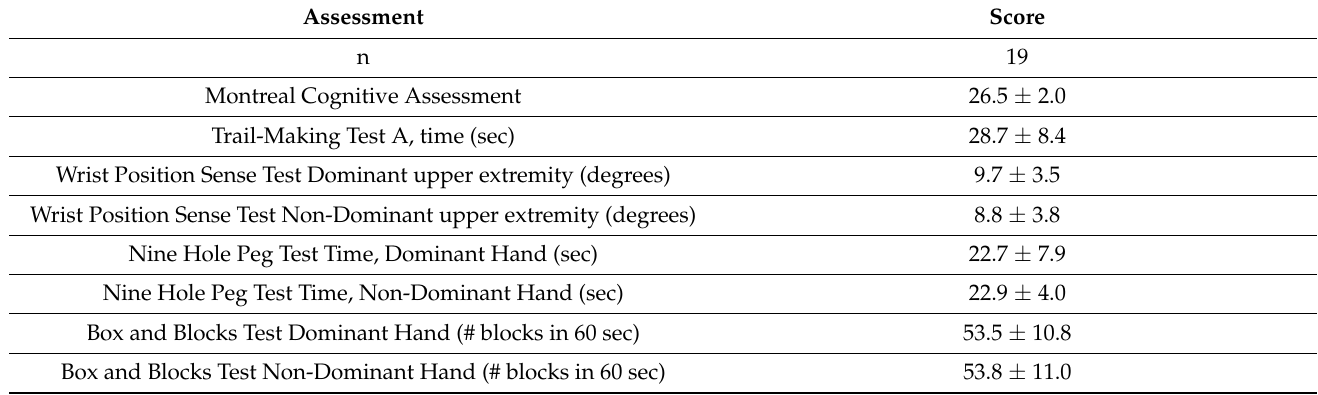
Table 3. Control Group Scores.